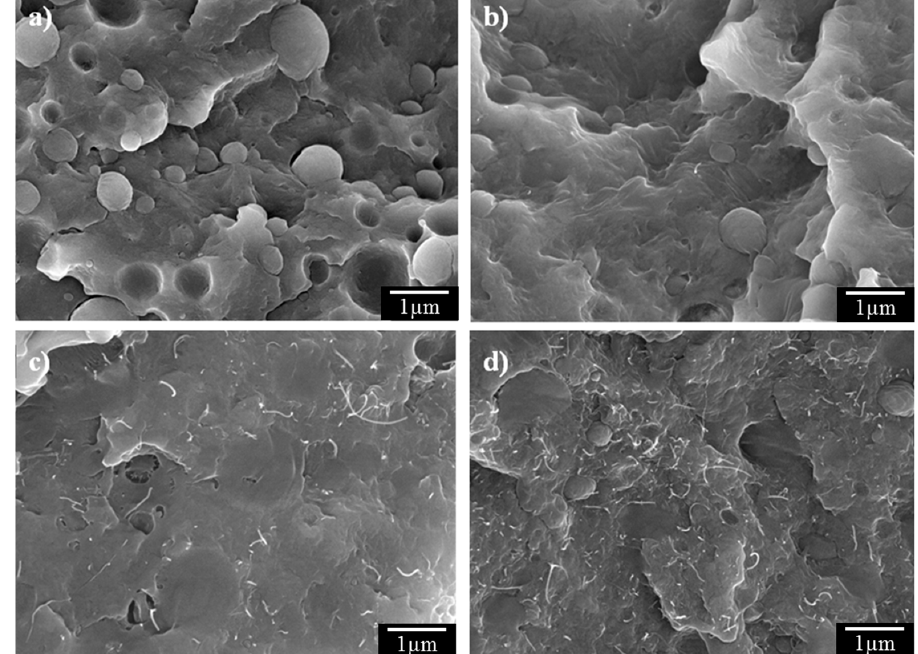
Figure 8. FE-SEM images of the fractured surfaces of CF-reinforced PA6/PP composites (30 wt % PP) with ( a ) 0 wt %, ( b ) 0.5 wt %, ( c ) 1 wt %, and ( d ) 1.5 wt % CNTs.